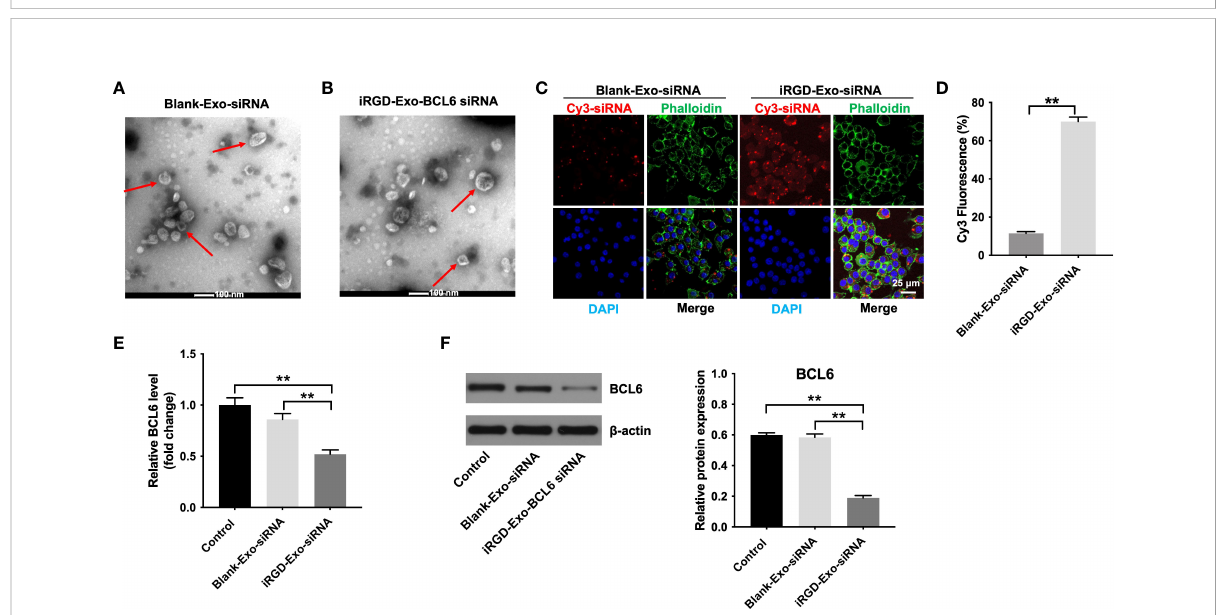
FIGURE 4 Binding of iRGD-Exos to a DLBCL cells in vitro . (A) The blank-Exo or (B) iRGD-Exo were electroporated with BCL6 siRNA1. TEM analysis was used to identify the morphology of exosomes (Scale bar, 100 nm; Red arrow: exosomes). NTA analysis was used to assess the number and size of exosomes. (C, D) The blank-Exo (blank-Exo-siRNA) or iRGD-Exo (iRGD-Exo-siRNA) were electroporated with Cy3-labeled BCL6 siRNA1. OCI- Ly8 cells were treated with Cy3-labeled BCL6 siRNA1 delivered with blank-Exos or iRGD-Exos for 72 h. Representative images were examined by a confocal microscope (Scale bar, 25 m m). (E) RT-qPCR and (F) western blot analysis of BCL6 levels in OCI-Ly8 cells treated with blank-Exo- siRNA and iRGD-Exo-siRNA. **P < 0.01. All tests were repeated in